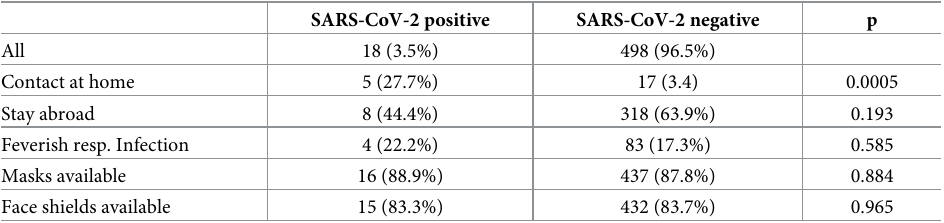
Table 3. Risk factors for SARS-CoV-2 positivity.